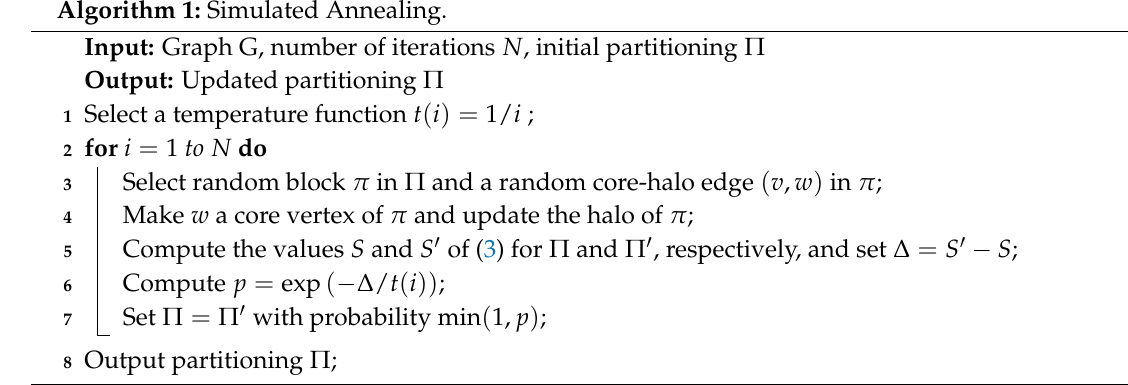
Algorithm 1: Simulated